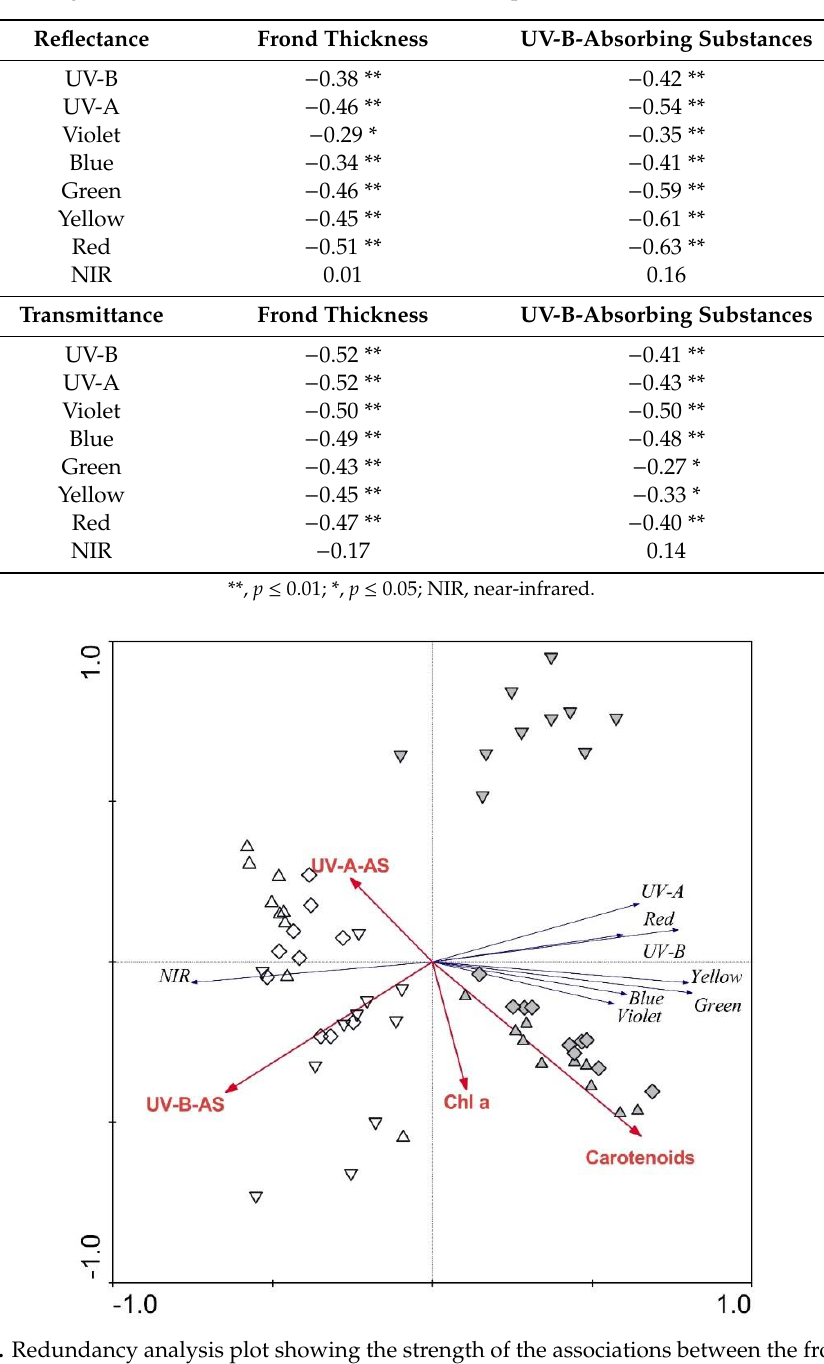
Table 3. Pearson’s correlation coe ffi cients for the Phyllitis scolopendrium fronds from the three habitats with di ff erent light conditions for the combined data from April and June.